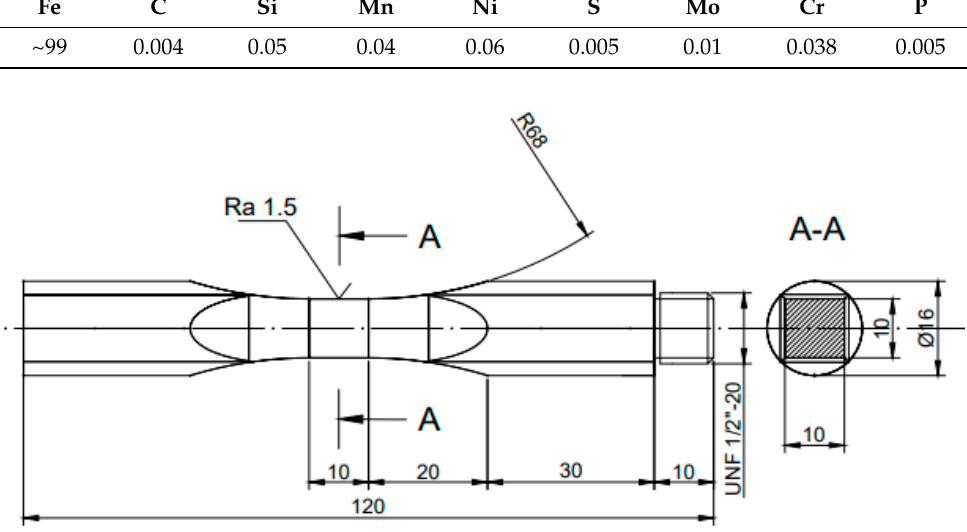
Figure 1. Geometry of samples for mechanical tests. All dimensions are in mm.